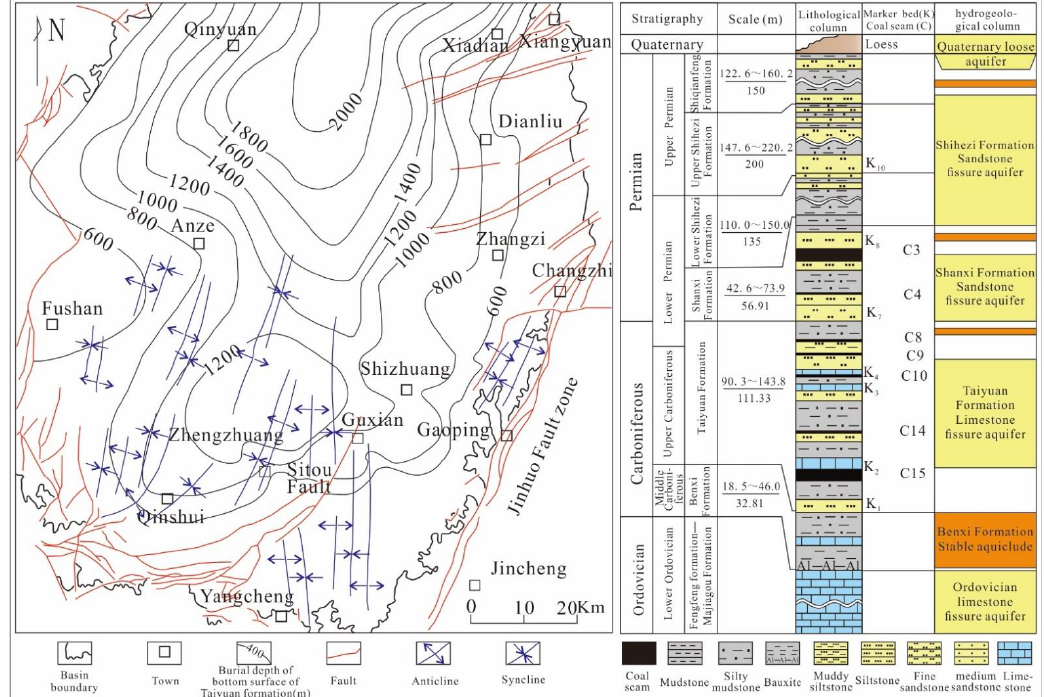
Figure 1. Tectonic map and stratigraphic column of the coal-bearing strata of the southern Qinshui Basin.